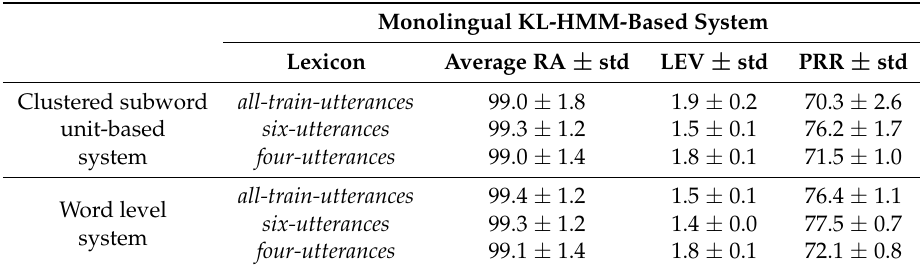
Table 5. Clustered subword unit-based and word level KL-HMM systems recognition accuracy (RA), Levenshtein distance (LEV) and phone recognition rate (PRR) on the PhoneBook database depending on the three different setups used to infer the lexicon ( all-train-/six-/four-utterances -based lexicon).